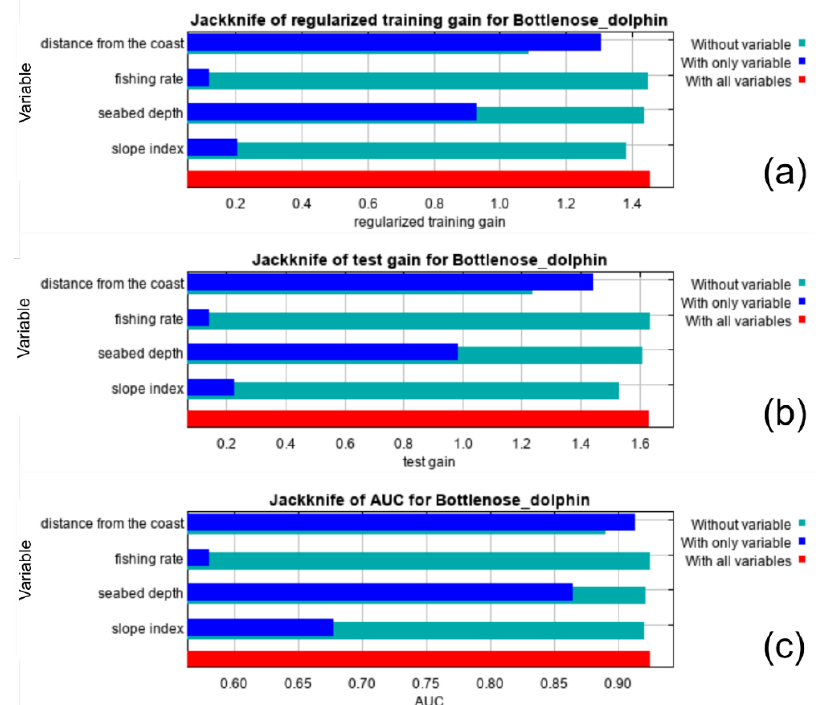
Figure 9. Results of the MaxEnt jackknife test of ( a ) regularized training gain, ( b ) test gain, and ( c ) AUC, for bottlenose dolphins. It shows the importance of each variable (distance from the coast, fishing rate, seabed depth, slope index) by excluding each variable (light blue), by considering only that variable (blue), and then by considering all the variables together (red).